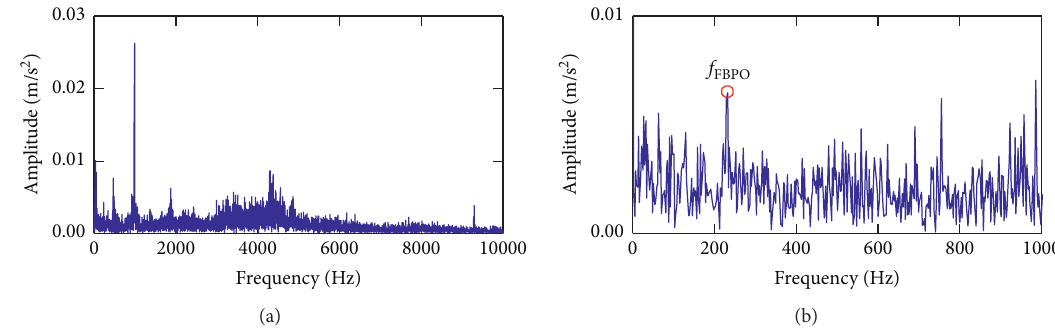
Figure 26: The experimental signal: (a) FFT spectrum; (b) envelope